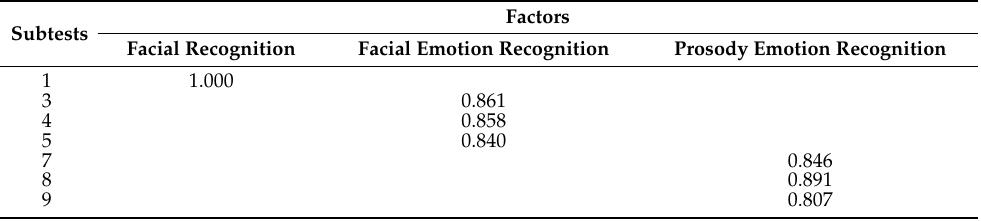
Table 6. Factor loadings for confirmatory factor analysis with models